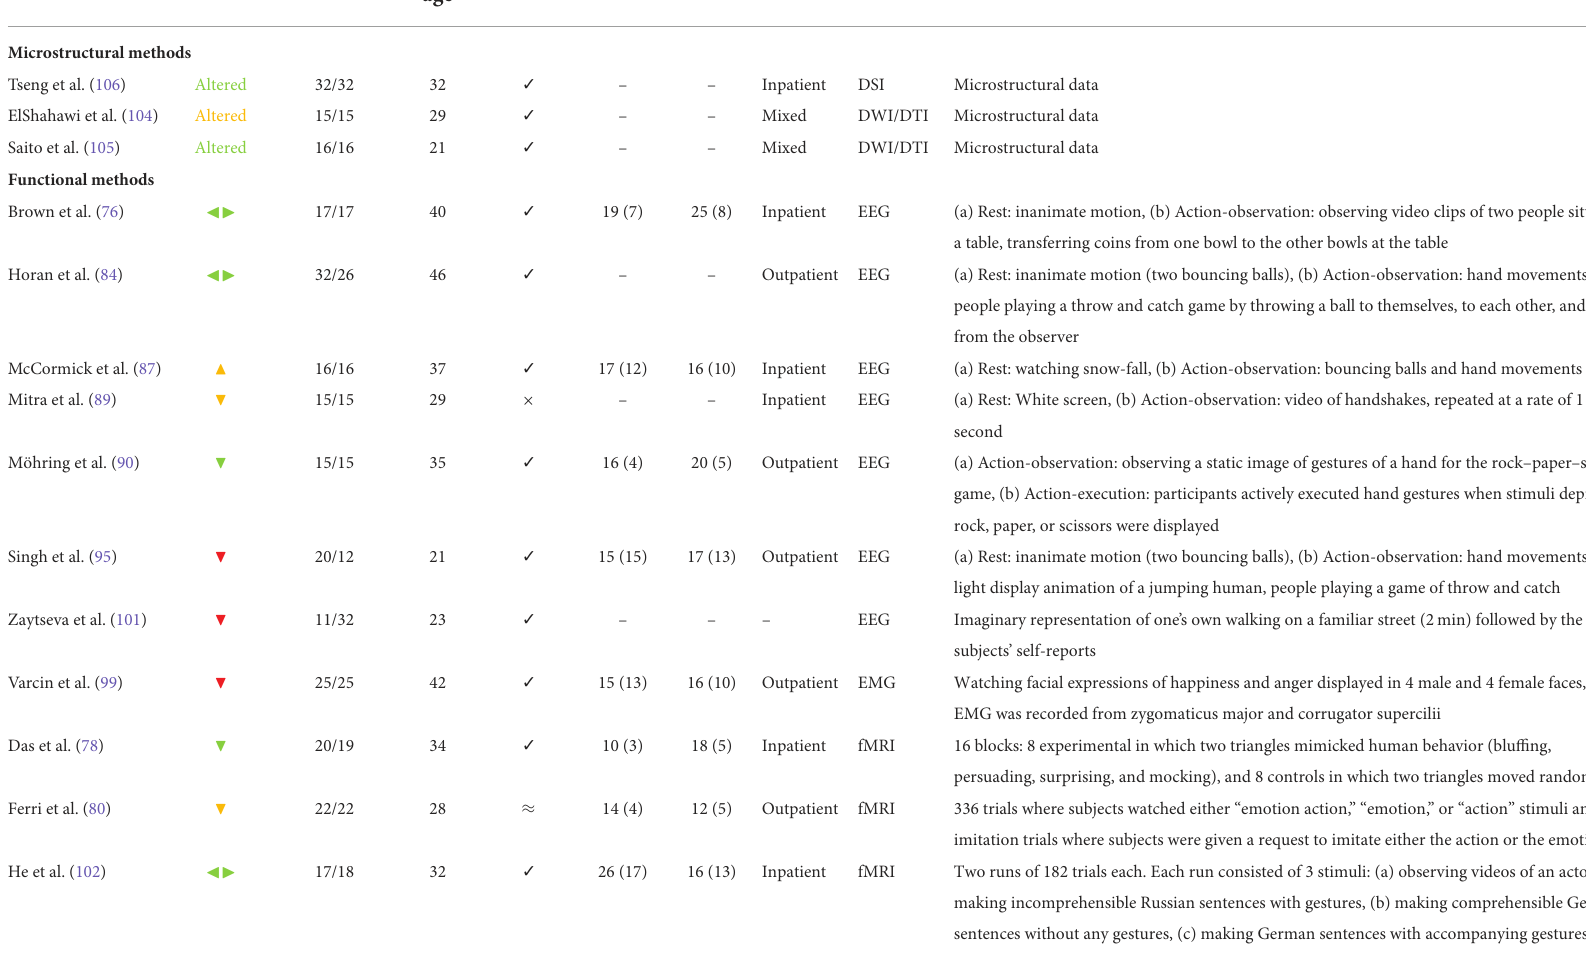
TABLE 1 The effect direction of the outcome table.